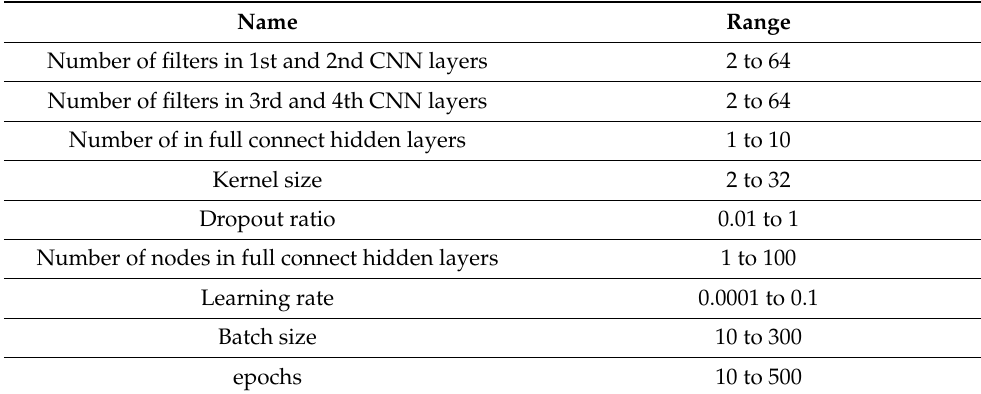
Table 3. Searching conditions of hyperparameters for Bayesian optimization.